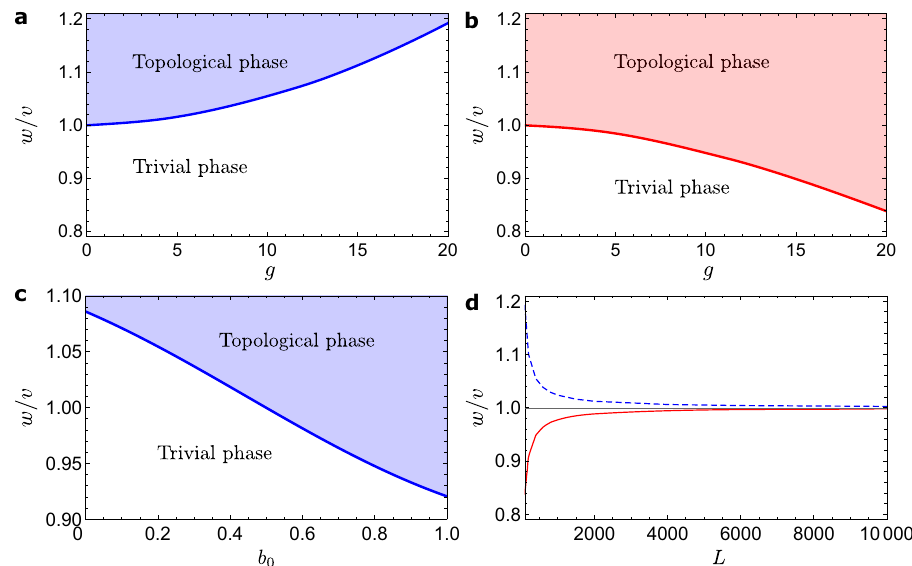
Fig. 3 Topological phase diagram of the Su-Schrieffer-Heeger model in presence of cavity. Topological phase diagram as a function of the light-matter coupling g and hopping ratio w / v for a the sublattice distance b 0 = 0.2 and b b 0 = 0.8. Trivial (white area) and topological phases ( a blue for b 0 = 0.2 and b red for b 0 = 0.8) are separated by the phase boundary (blue and red lines) given by Eq. (13). Phase boundary is shifted to larger (smaller) values of w / v for b 0 = 0.2 ( b 0 = 0.8). c Topological phase diagram as a function of b 0 and w / v for a fi xed value of the light-matter coupling g = 10. The topological phase is entered at smaller (larger) values of w / v for b 0 > 0.5 ( b 0 < 0.5). d Topological phase diagram as a function of the number of unit cells L and w / v for g = 20. Phase boundary goes to w / v = 1 for large values of L for b 0 = 0.2 (blue dashed line) and b 0 = 0.8 (red solid line). Other parameters are fi xed as intracell hopping v = 1, lattice constant a 0 = 1, cavity frequency ω c = 0.5, maximum number of photons N max = 10, and L = 100 (except panel d